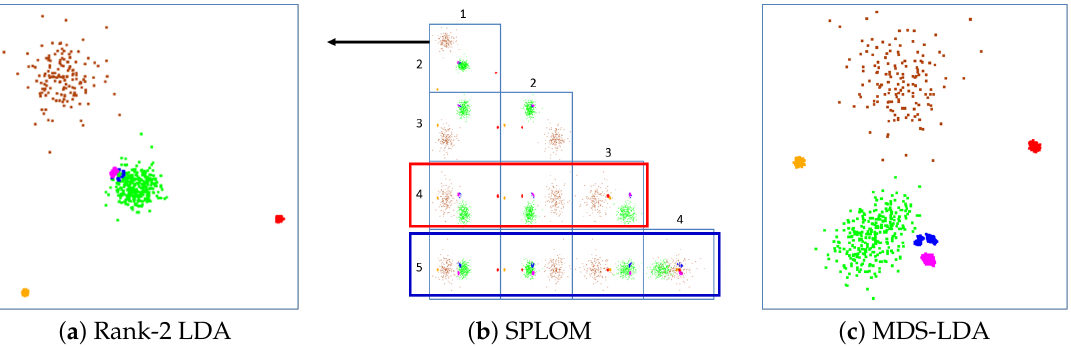
Figure 2. Artificial dataset with 6 Gaussian clusters originally in 30-D space gives rise to a 5-D LDA embedding. ( a ) Rank-2 LDA. Three clusters—the green, blue and magenta clusters—are overplotted. ( b ) 5-D SPLOM. The top scatterplot is Rank-2 LDA ( a ). None of the scatterplot projections can successfully isolate all clusters, ( c ) MDS-LDA. We observe that all clusters are now well